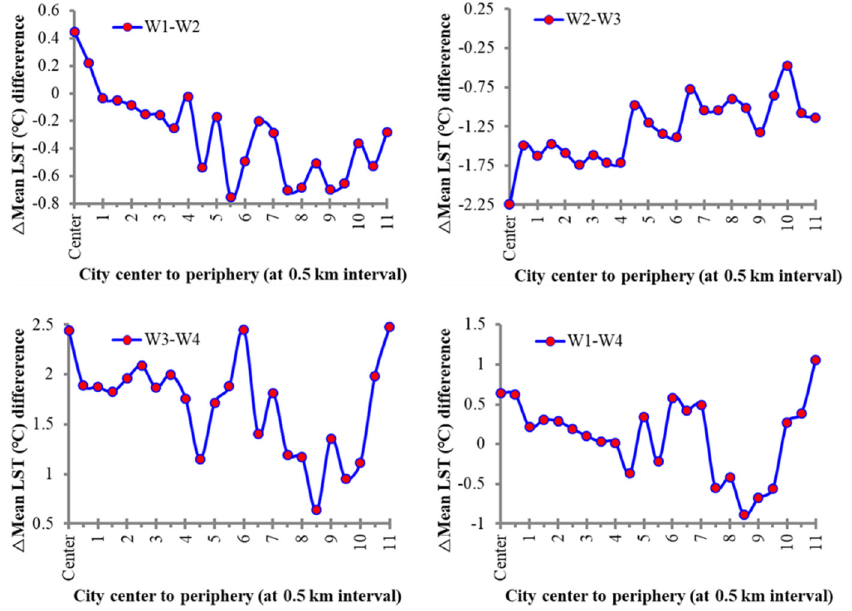
Figure 6. Magnitude of the winter mean LST in different periods